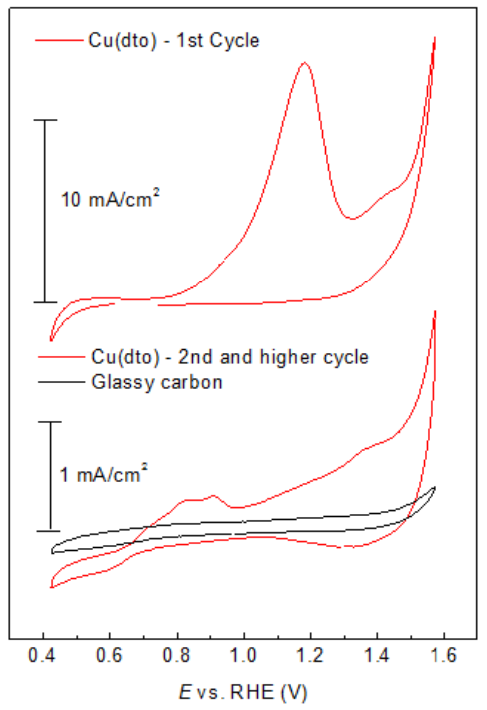
Figure 2. Cyclic voltammograms of the Cu(dto)/C electrode and a glassy carbon electrode at a scan rate of 5 mV/s, in N 2 -saturated 1 M KOH.